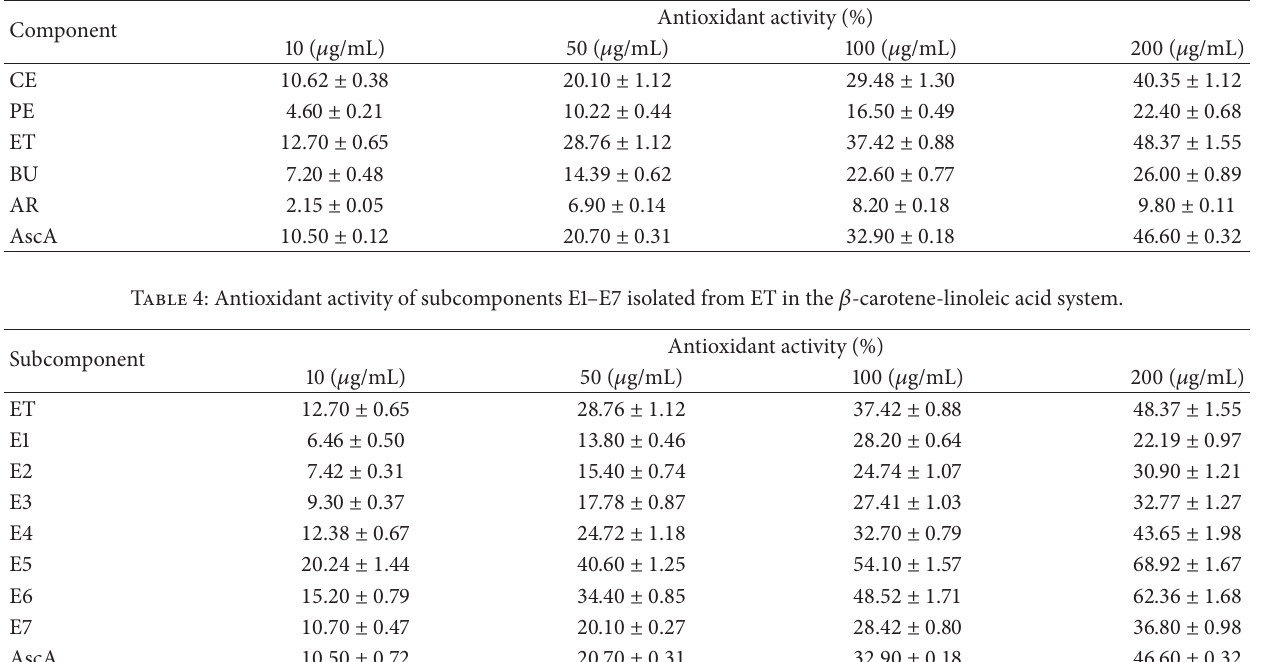
Table 3: Antioxidant activity of different components isolated from S. clava in the 𝛽 -carotene-linoleic acid system.